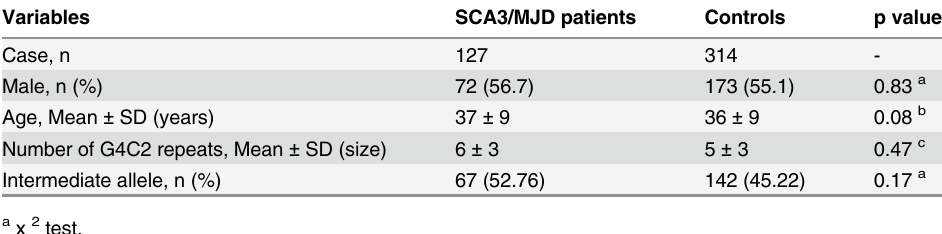
Table 1. Demographic information and average number of repeats between SCA3/MJD patients and